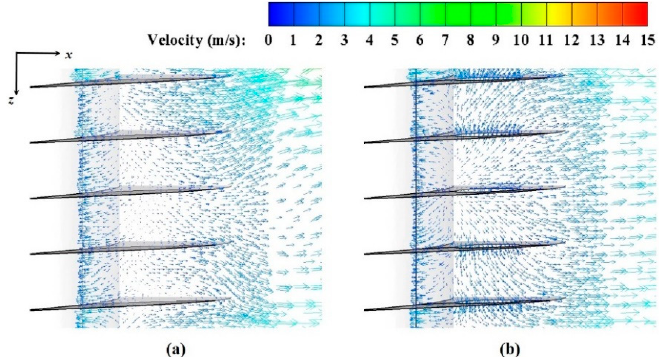
Figure 7. Comparison of velocity vectors at Re = 11,440. ( a ) Case 1(ref.) at y = 0.007269 m; ( b ) Case 4 at y = 0.007269 m located in wake region.